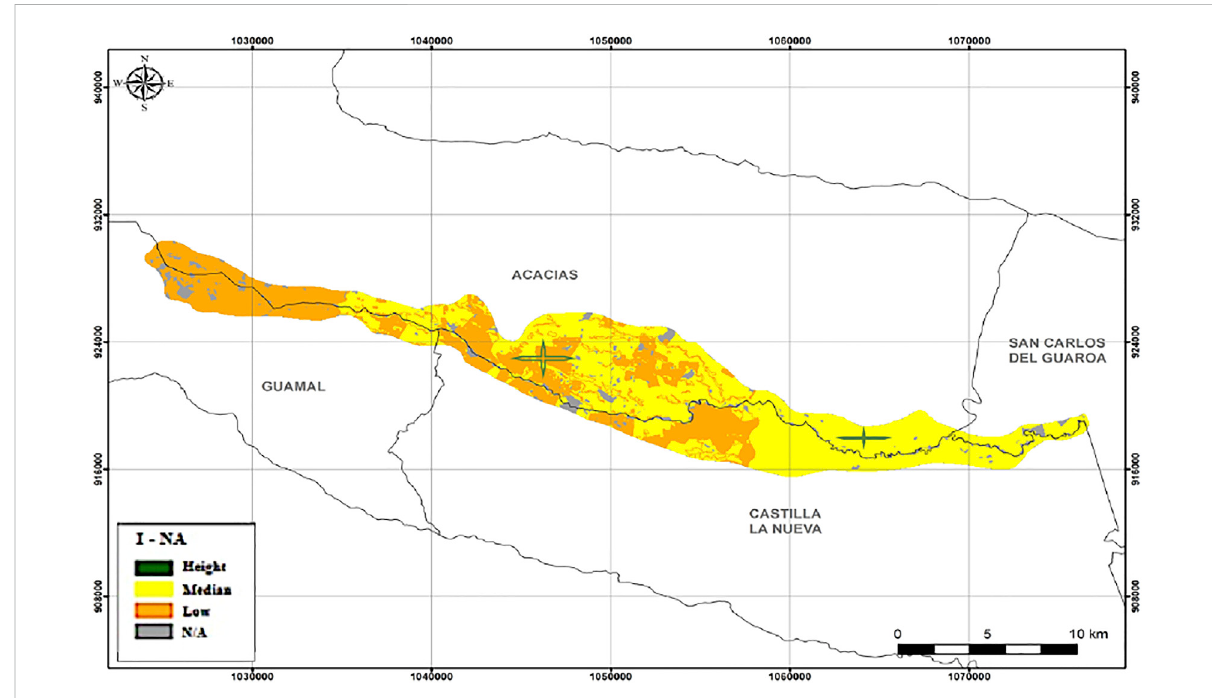
FIGURE 7 Orotoy riverbasin: 1:25,000 cartographicrepresentation ofthesoil ESassessmentindicator “ storagecapacityofnutrientsand organicmatter. ” for ESPUs Window and Coverages. Arrows indicate trade-offs and the direction of their fl ow. Source: Elaborated by the